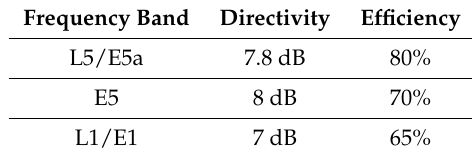
Figure 3. Measured antenna radiation pattern of one of the manufactured antennas at L1/E1 ( a ), and at L5/E5 ( b ). Table 1. Measured directivity and estimated efficiency of the antenna elements.